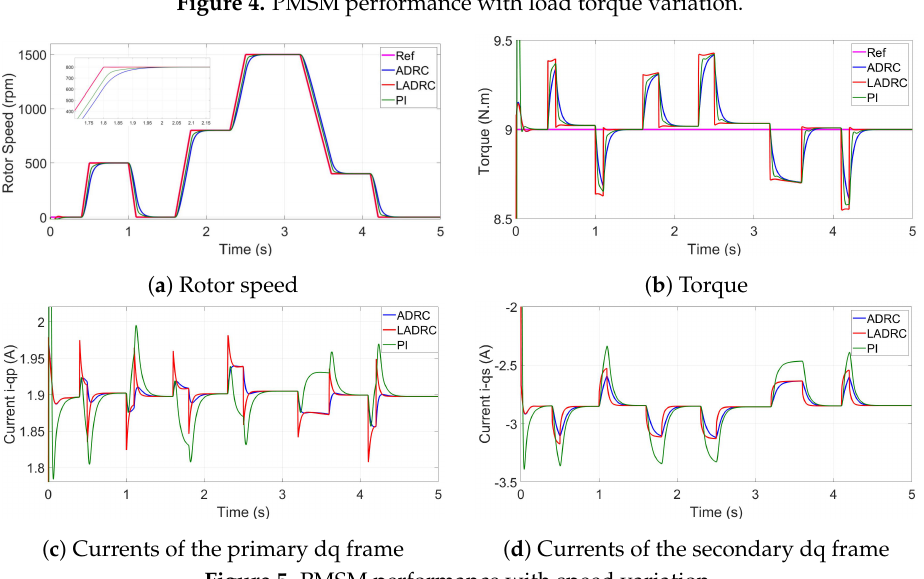
Figure 5. PMSM performance with speed